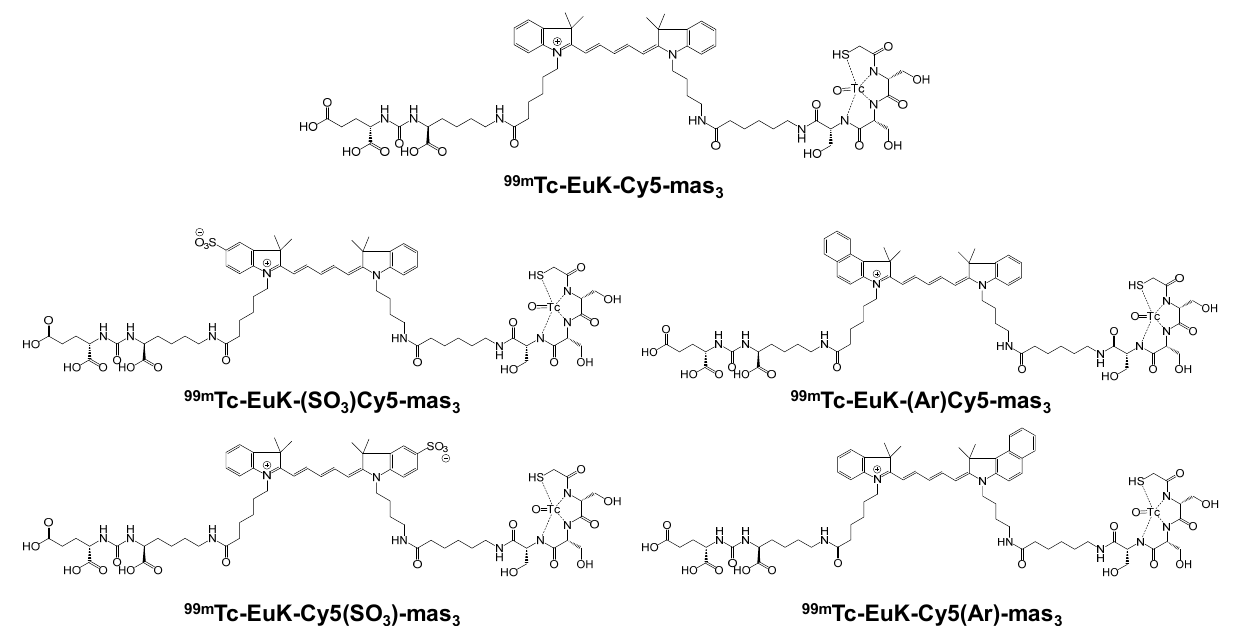
Figure 12. Schematic drawing of bimodal hybrid tracer based on fluorescent Cy5 dye.